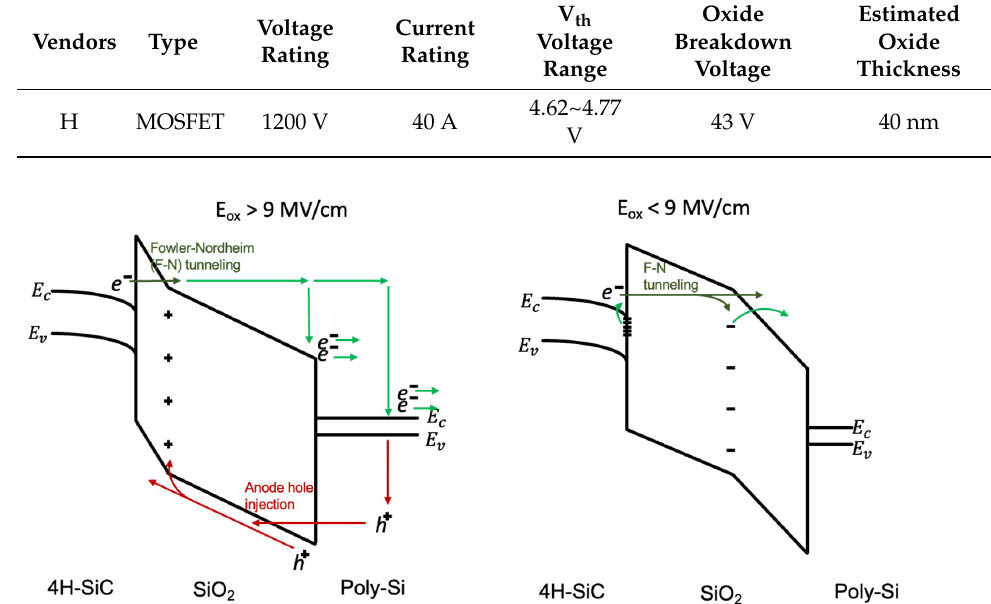
Figure 13. Schematic diagram showing gate leakage behavior where oxide electric field is above and below the critical electric field of 9 MV/cm.